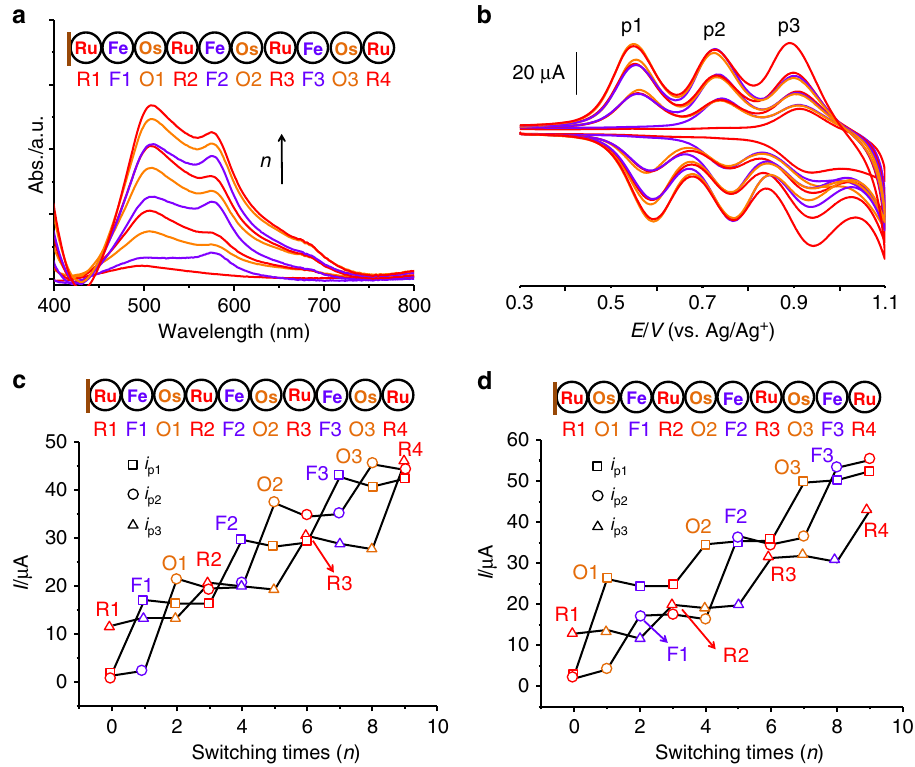
Fig. 4 Electrosynthesis of ternary organometallic polymers. a , b Illustrations of UV – vis absorbance (left) and CV (right) as a function of switching times during iterative synthesis. c , d Illustrations of current intensities as a function of switching times during iterative synthesis of organometallic polymers with different